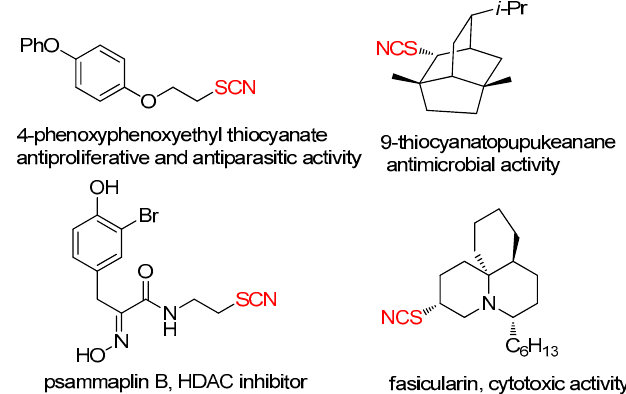
Figure 1. Representative bioactive alkyl thiocyanates.